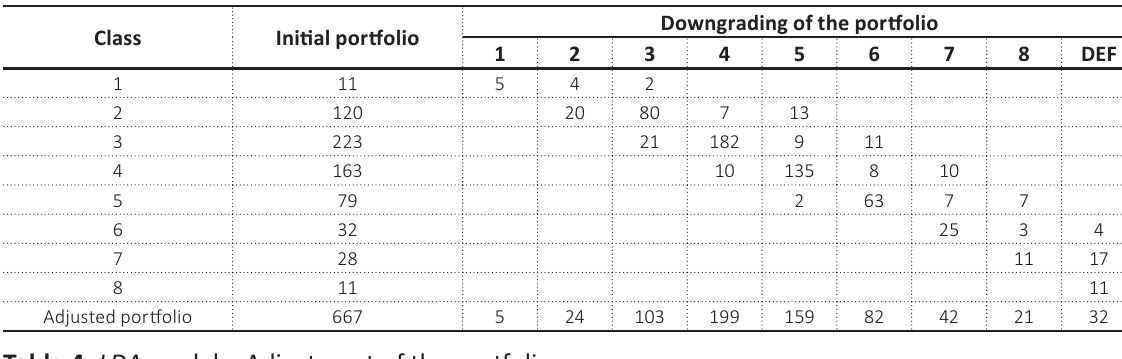
Table 4. LDA model – Adjustment of the portfolio